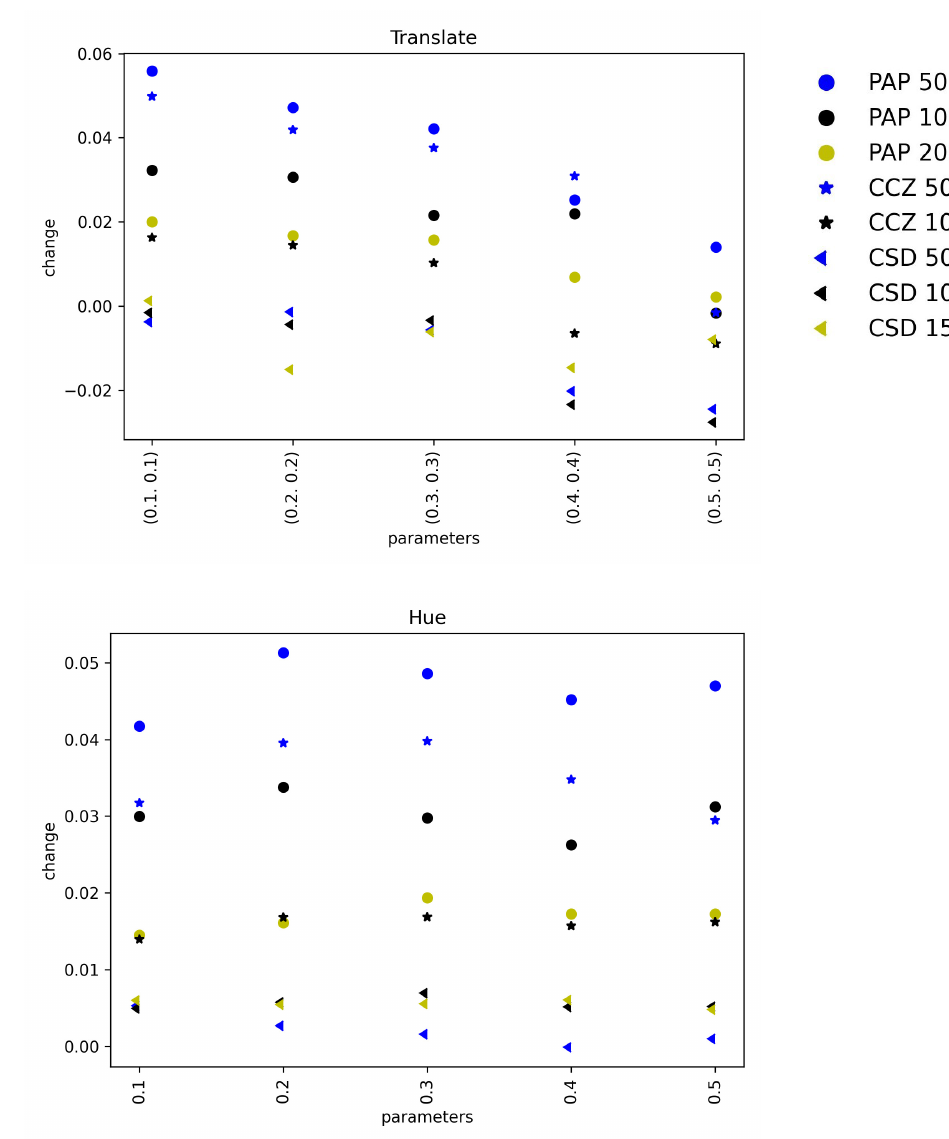
Figure A2. Impacts comparison of Translate and Hue. The figure shows the performance of the different parameters of Translate and Hue on the three